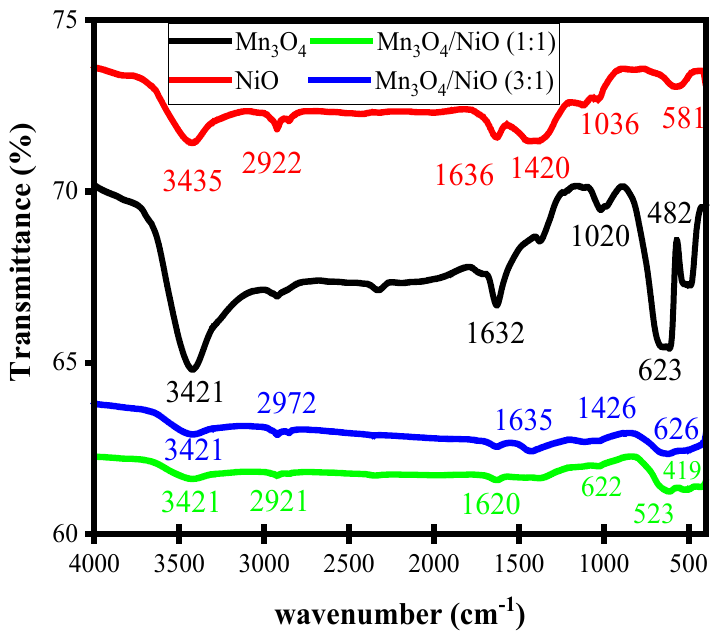
Figure 5. FTIR spectra of pure Mn 3 O 4 NPs, NiO NPs, and Mn 3 O 4 /NiO NCs (1:1) and